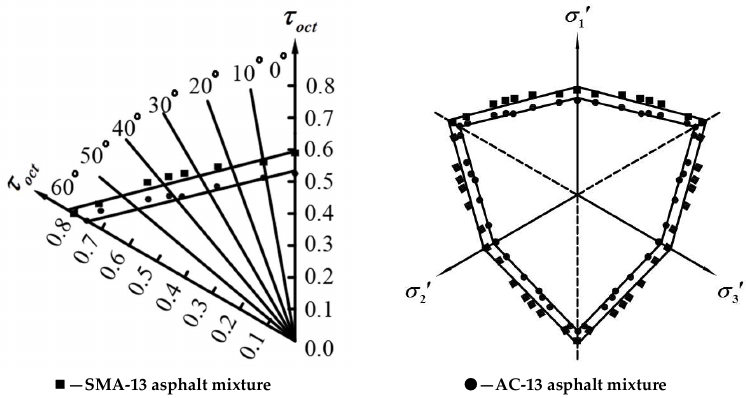
Figure 10. Linear strength envelope curves in the π -plane.